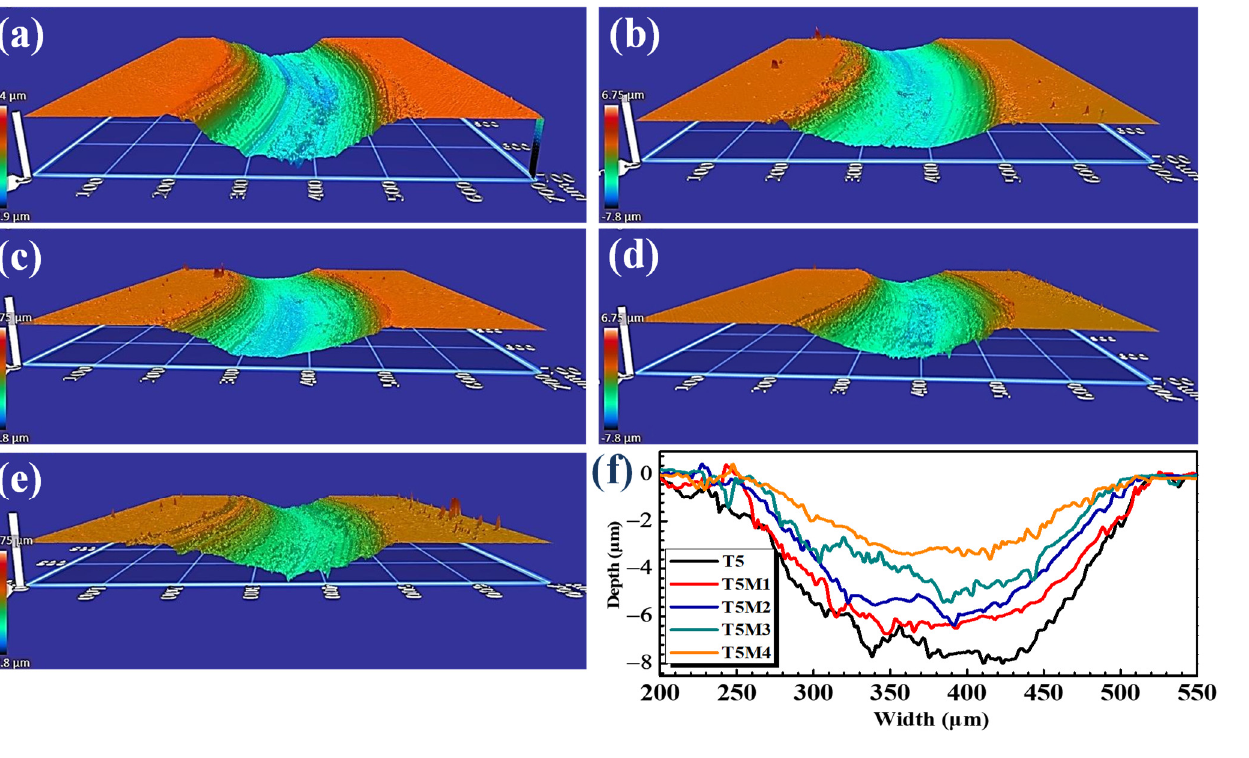
Figure 8. Three-dimensional images of wear scars on five samples after wear tests over a sliding distance of 45 m. ( a ) AlCrFeNiTi 0.5 , ( b ) AlCrFeNiTi 0.5 Mo 0.1 , ( c ) AlCrFeNiTi 0.5 Mo 0.2 , ( d ) AlCrFeNiTi 0.5 Mo 0.3 , and ( e ) AlCrFeNiTi 0.5 Mo 0.4 alloys. ( f ) Cross-sectional profiles of wear tracks on the five samples.